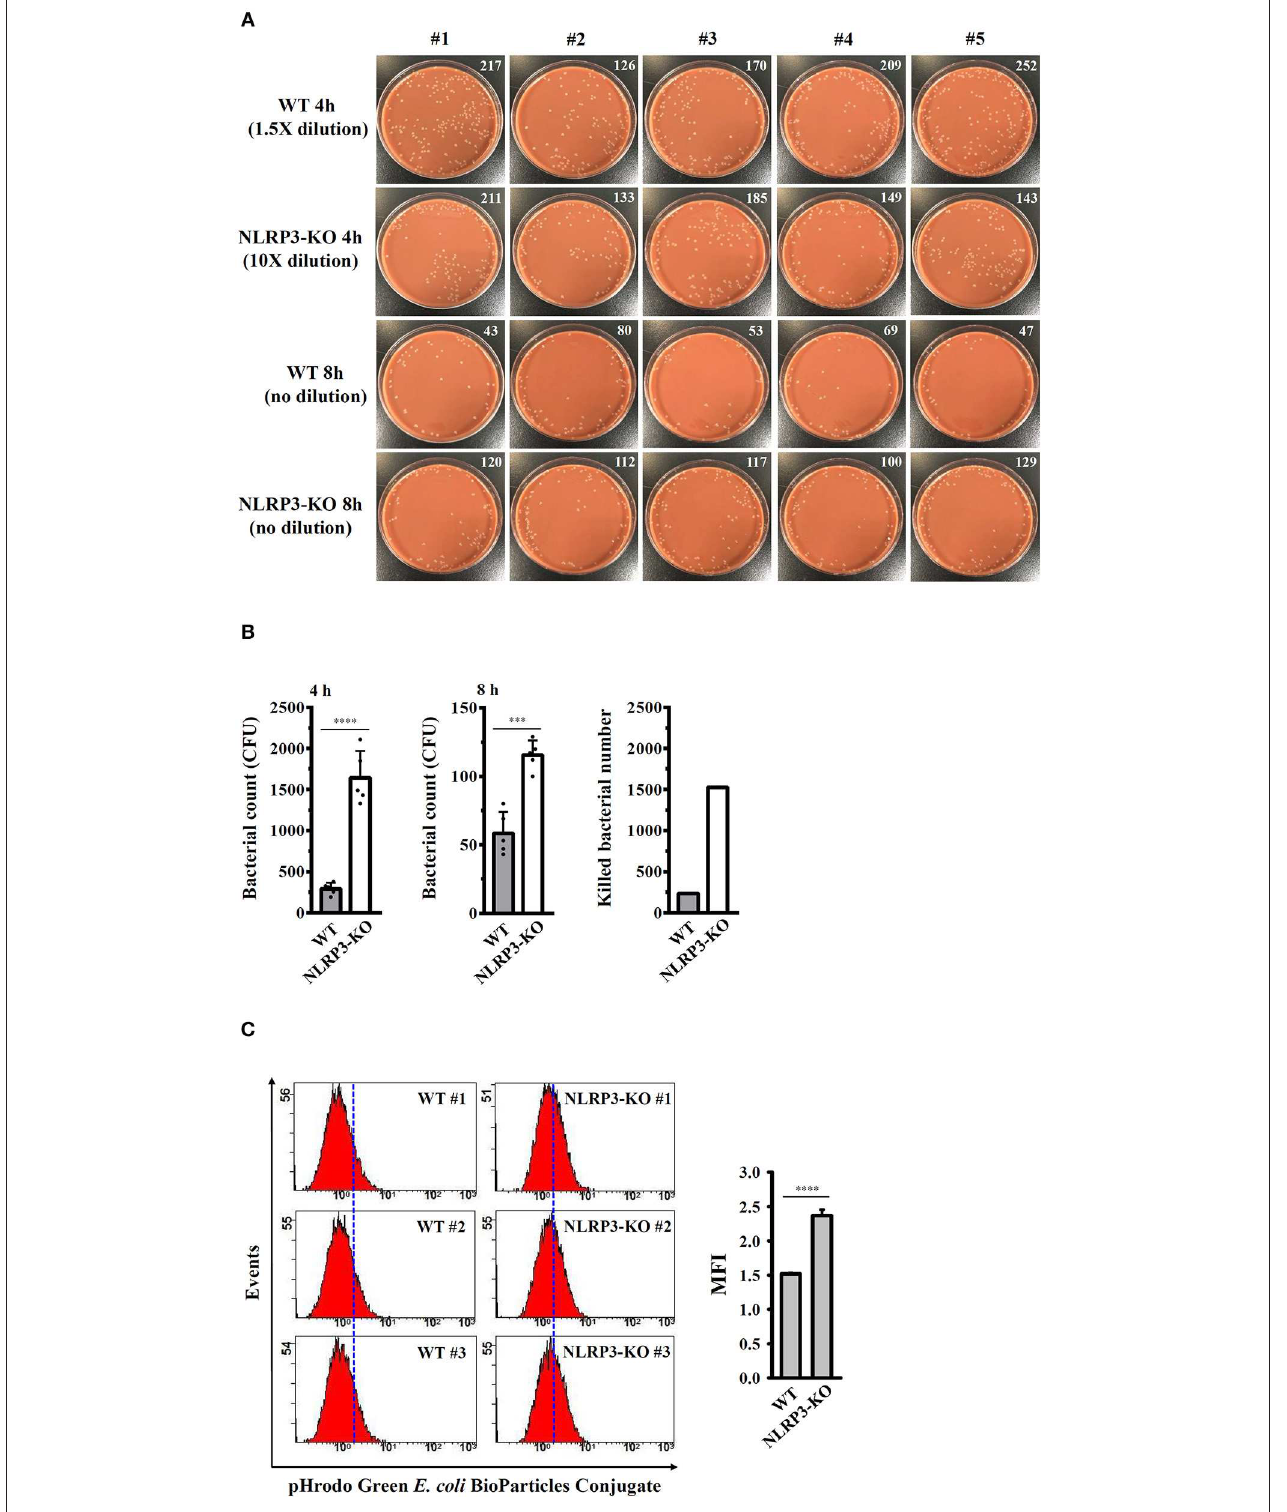
FIGURE 9 | NLRP3 knockout increases the bactericidal activity of macrophages against NG. (A,B) Wild-type and NLRP3-knockout (NLRP3-KO) J774A.1 macrophages were infected with NG for 4h and 8h. The cells were lysed, and the number of engulfed live NG was determined by CFU assay and indicated in